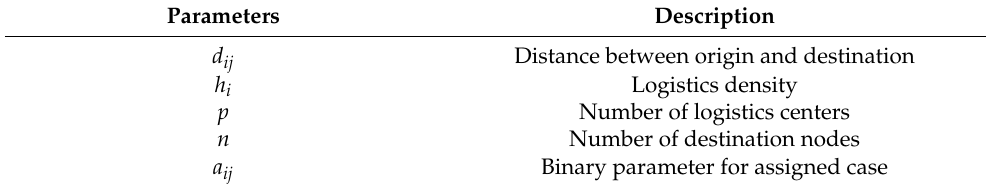
Table 3. Parameter descriptions. Parameters Description